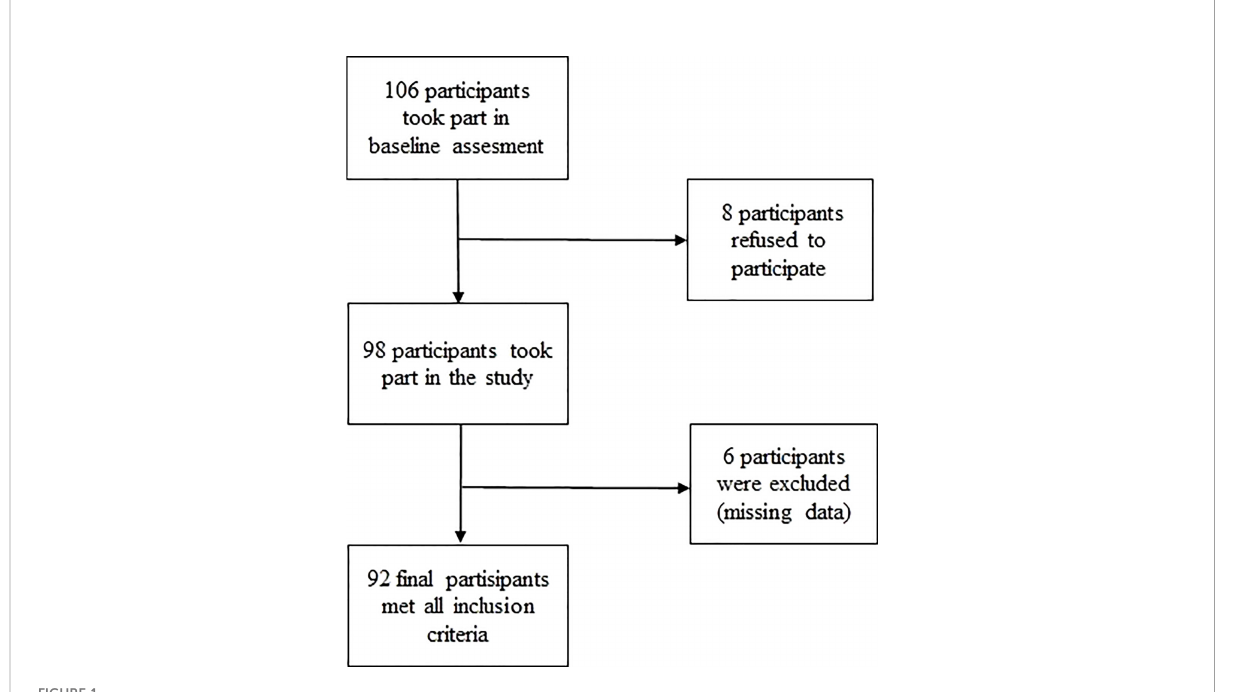
FIGURE 1 Flow chart of patients ’